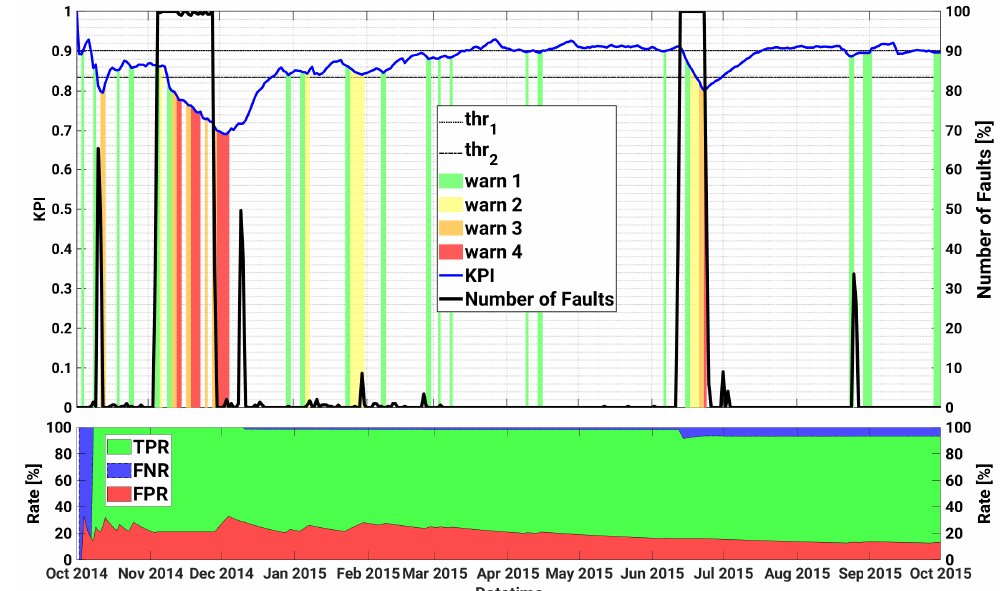
Figure 3. Historical case studies for inverter A.2 of plant A. Top plot—Left axis: KPI, as well as the warning levels and the upper and lower thresholds are shown as a function of datetime; Right axis: time series of daily number of faults. Bottom plot: TPR, FNR and FPR as a function of